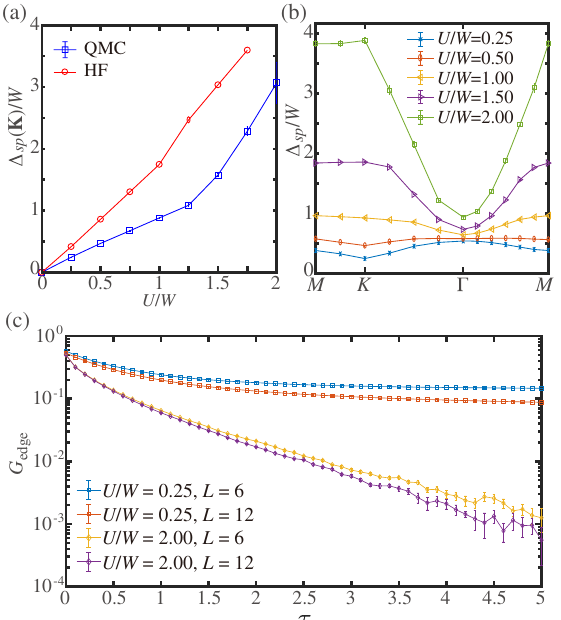
FIG. 2. QVH and gapless edge states. (a) Single-particle gap Δ K Þ =W at the K point as a function of U=W for α ¼ 0 . 45 , sp ð extracted from both QMC (blue points) and HF calculations (red points). For QMC, the spatial system size is L ¼ 12 . The Dirac semimetal is gapped out at the smallest U values probed. (b) Single-particle gap extracted from QMC with L ¼ 12 along a high-symmetry path of the Brillouin zone. (c) Topological nature of the QVH phase manifested by valley-polarized edge states. Here, we compare the edge Green ’ s function for valley l ¼ 1 and spin ↑ at U=W ¼ 0 . 25 (inside the QVH phase) and U=W ¼ 2 . 0 (inside the IVC phase). It is clear that gapless edge modes only appear in the former case, highlighting the topo- logical nature of the QVH